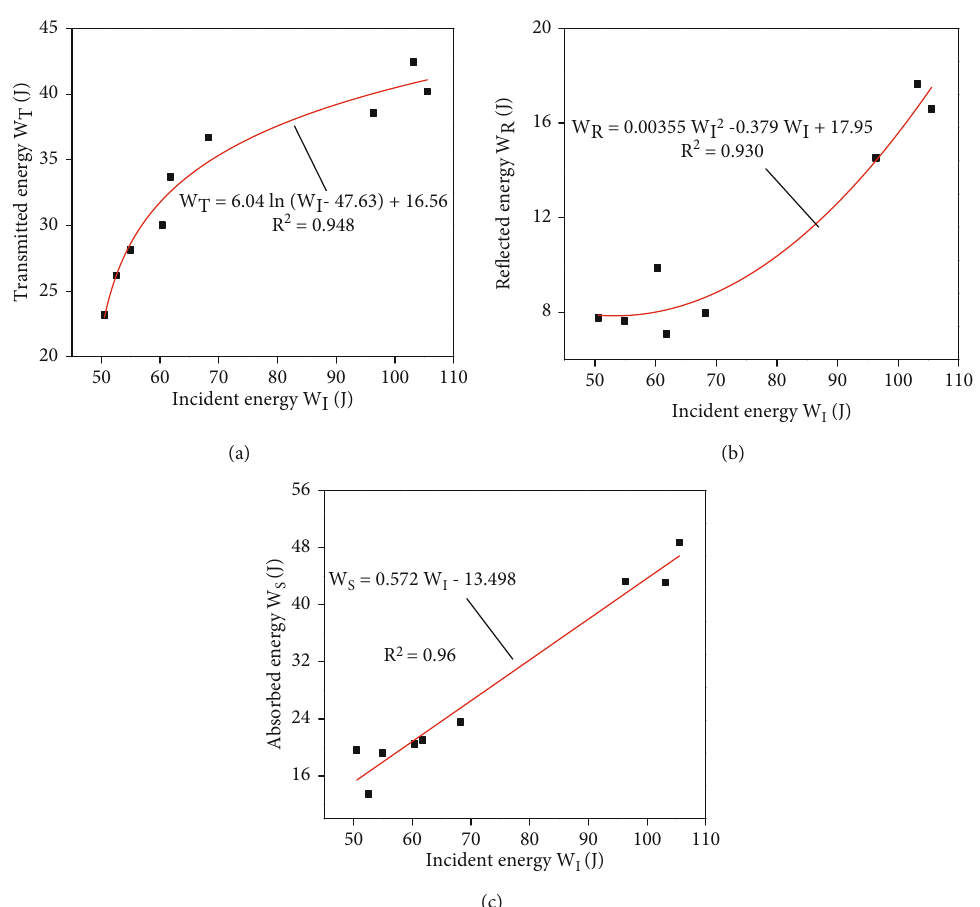
Figure 12: The relationships between incident energy and transmitted energy, re fl ected energy, and absorbed energy.